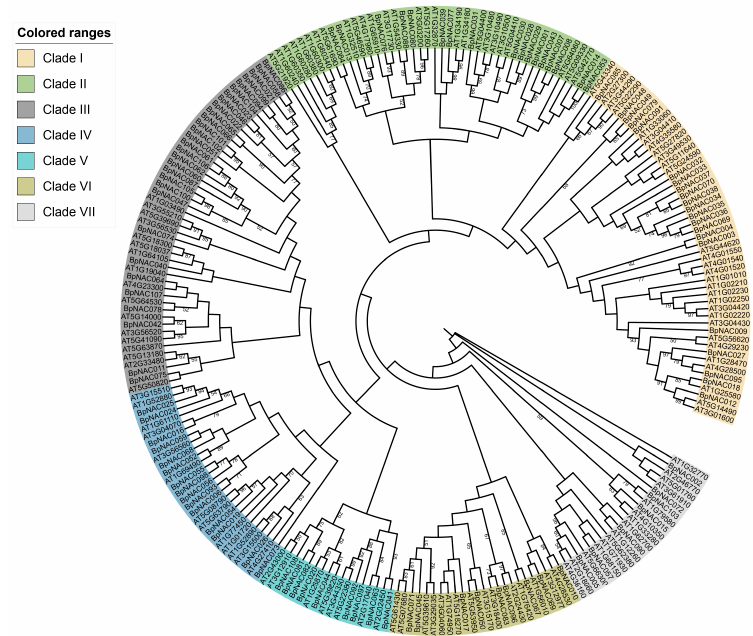
Figure 1. The phylogenetic tree of BpNACs and AtNACs made by RAxML using the maximum likelihood algorithm. Its confidence was evaluated with 1000 bootstraps.